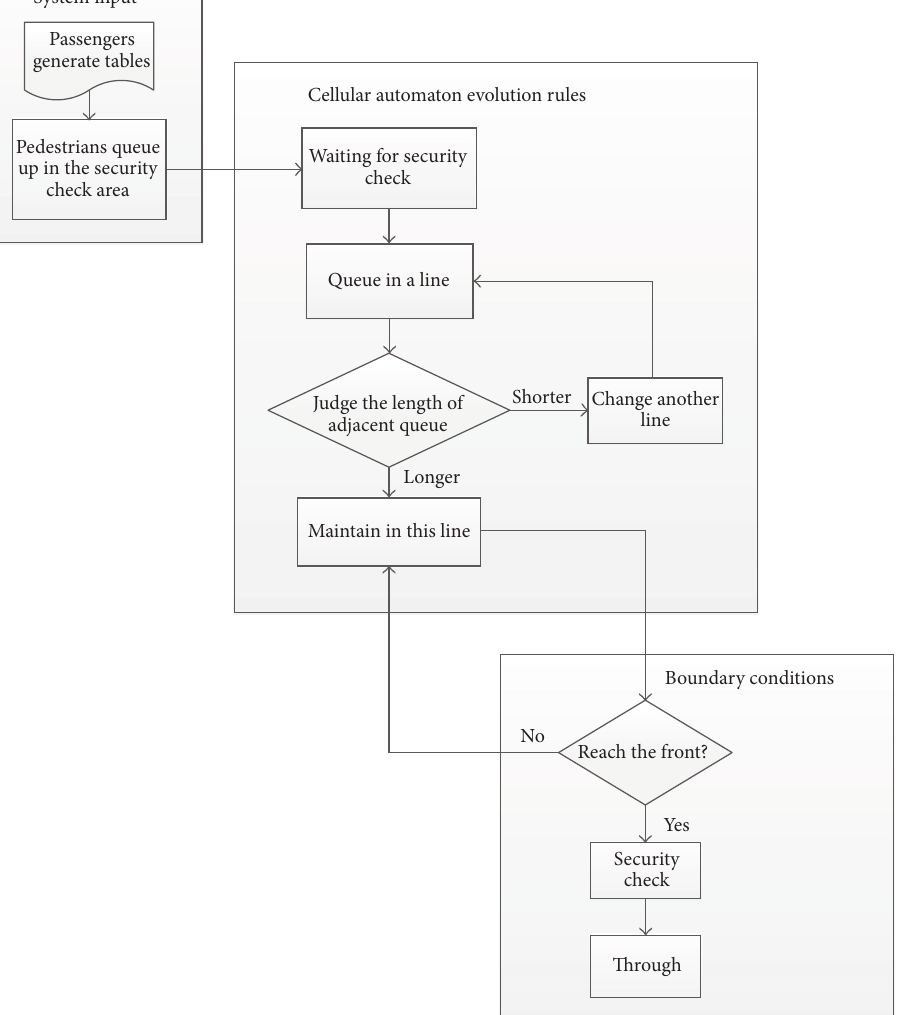
Figure 8: Process of passengers’ security check